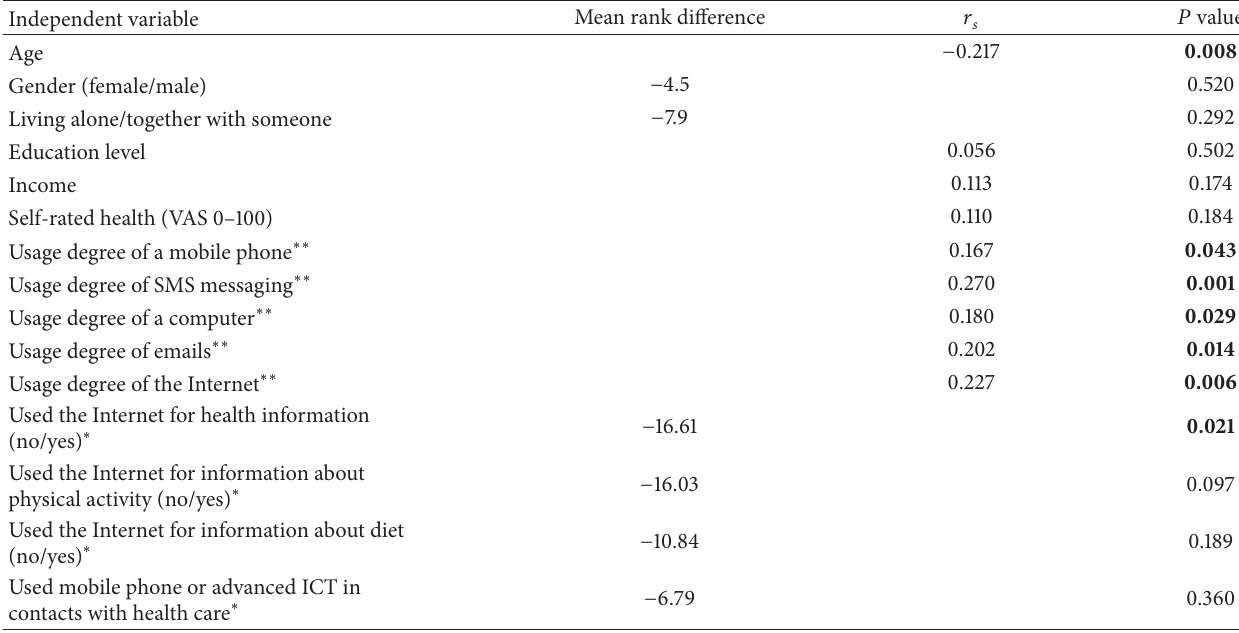
Table 3: Associations between PIADS total score for web-based e-health services in present scenario and respondents’ profile variables (𝑛 = 147) . Independent variable